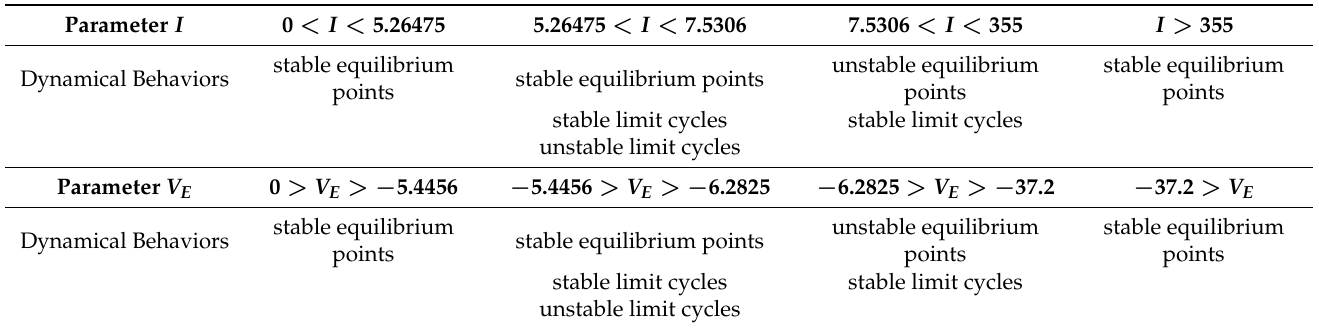
Figure 6. Bifurcation diagram for parameter V E . ( a ) The V E –V max , V E –V min curves and equilibrium points of model (28). ( b ) A locally enlarged view of ( a ) near Hopf point B. Consider V E ≈ − 5.4456 and V E ≈ − 6.2825, respectively. When − 5.4456 < V E < 0, the equilibrium points of model (28) are stable. When − 6.2825 < V E < − 5.4456, the equi- librium points of model (28) are stable, and the limit cycles near the equilibrium points are unstable. However, model (28) has stable limit cycles that are totally different from the limit cycles near the equilibrium points. The reason is that model (28) has canard points. When − 37.2 < V E < − 6.2825, model (28) has unstable equilibrium points and stable limit cycles. The stable equilibrium points become unstable equilibrium points, and the unstable limit vanish when model (28) passes a Hopf bifurcation near V E ≈ − 6.2825. The dynamic behaviors of model (28) about the parameters I and V E are summarized in Table 2. Table 2. The dynamic behaviors of model (28) about the parameters I and V E